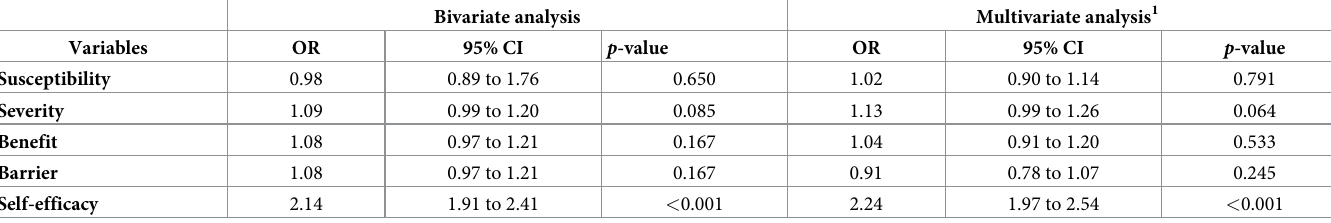
Table 2. Associations between tooth brushing behavior of children and oral health belief of